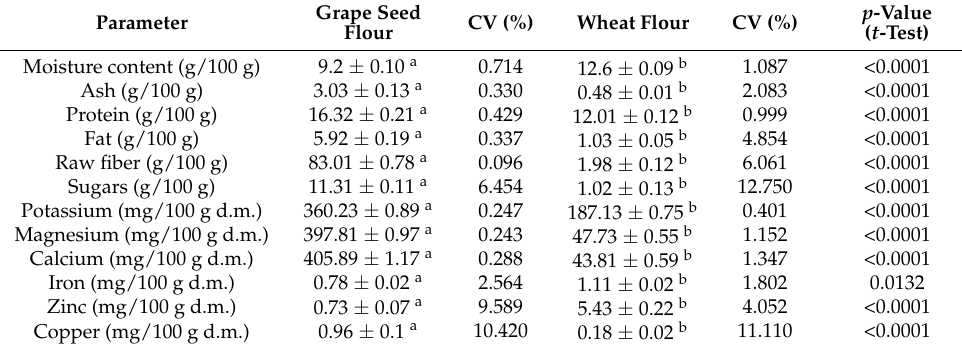
Table 4. Chemical composition of the grape seed and wheat